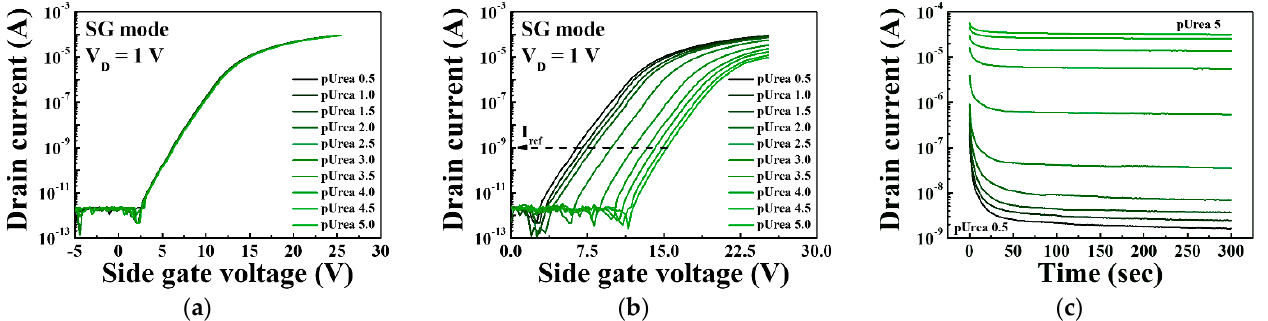
Figure 9. Transfer characteristic curves of the triple-gate a-IGZO TFT-based urea-EnFET sensor platform under the SG mode for ( a ) the interaction between the SnO 2 membrane and urea and ( b ) the interaction between urease and urea (control test). ( c ) Drain current variation over time for various urea concentrations to confirm the response time needed to reach the equilibrium state of the reaction.